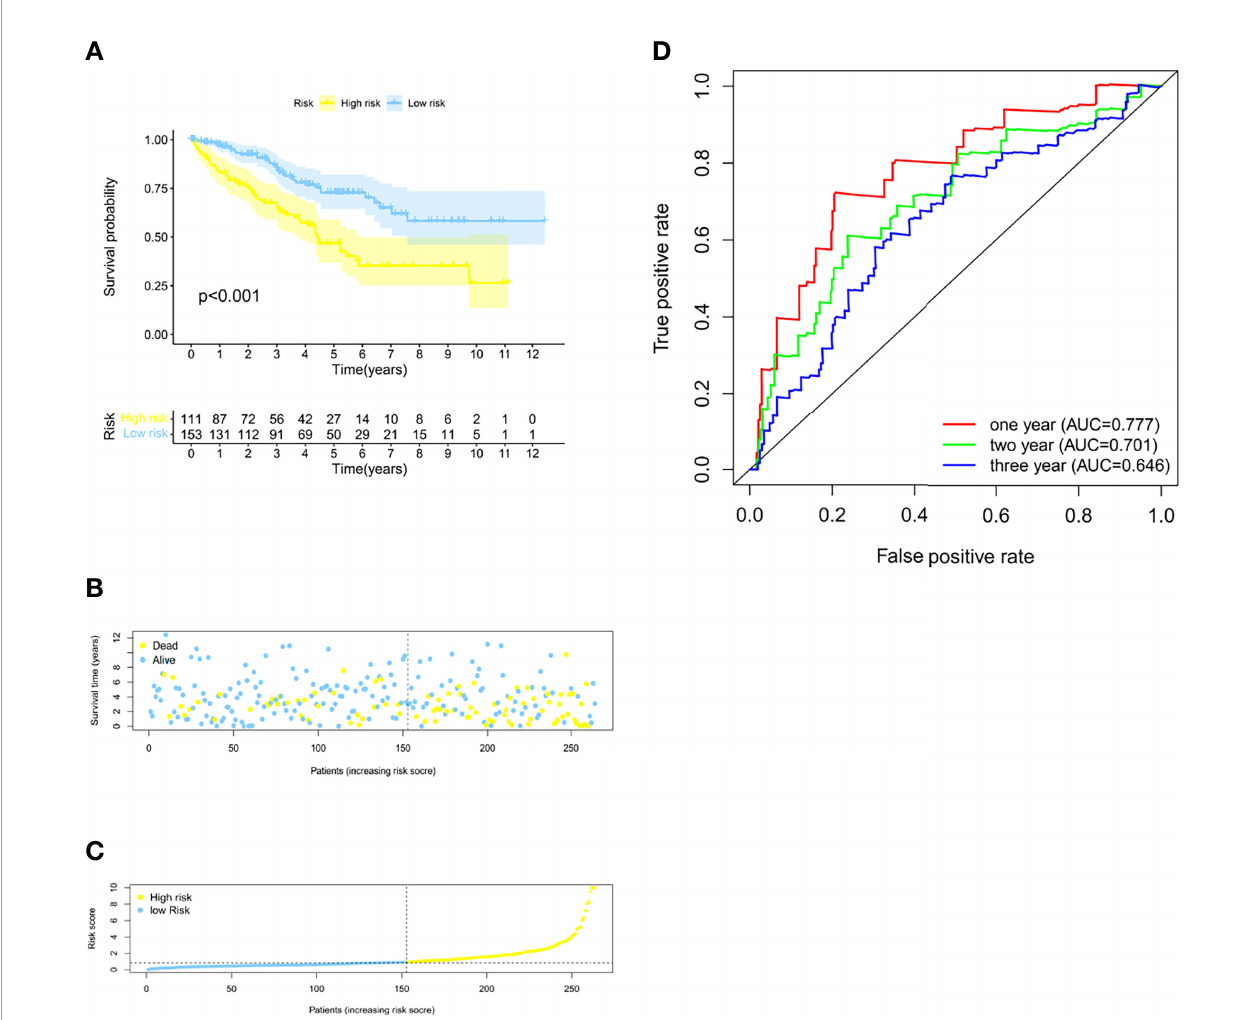
FIGURE 2 | Validation of the model in the testing group. (A) The Kaplan – Meier survival curves for the two risk groups in the testing sets ( p < 0.001). (B) The risk score plot of the testing set. (C) Survival time and status of patients in the testing set. (D) Time-dependent ROC curves of overall survival at 1, 2, and 3 years in the testing